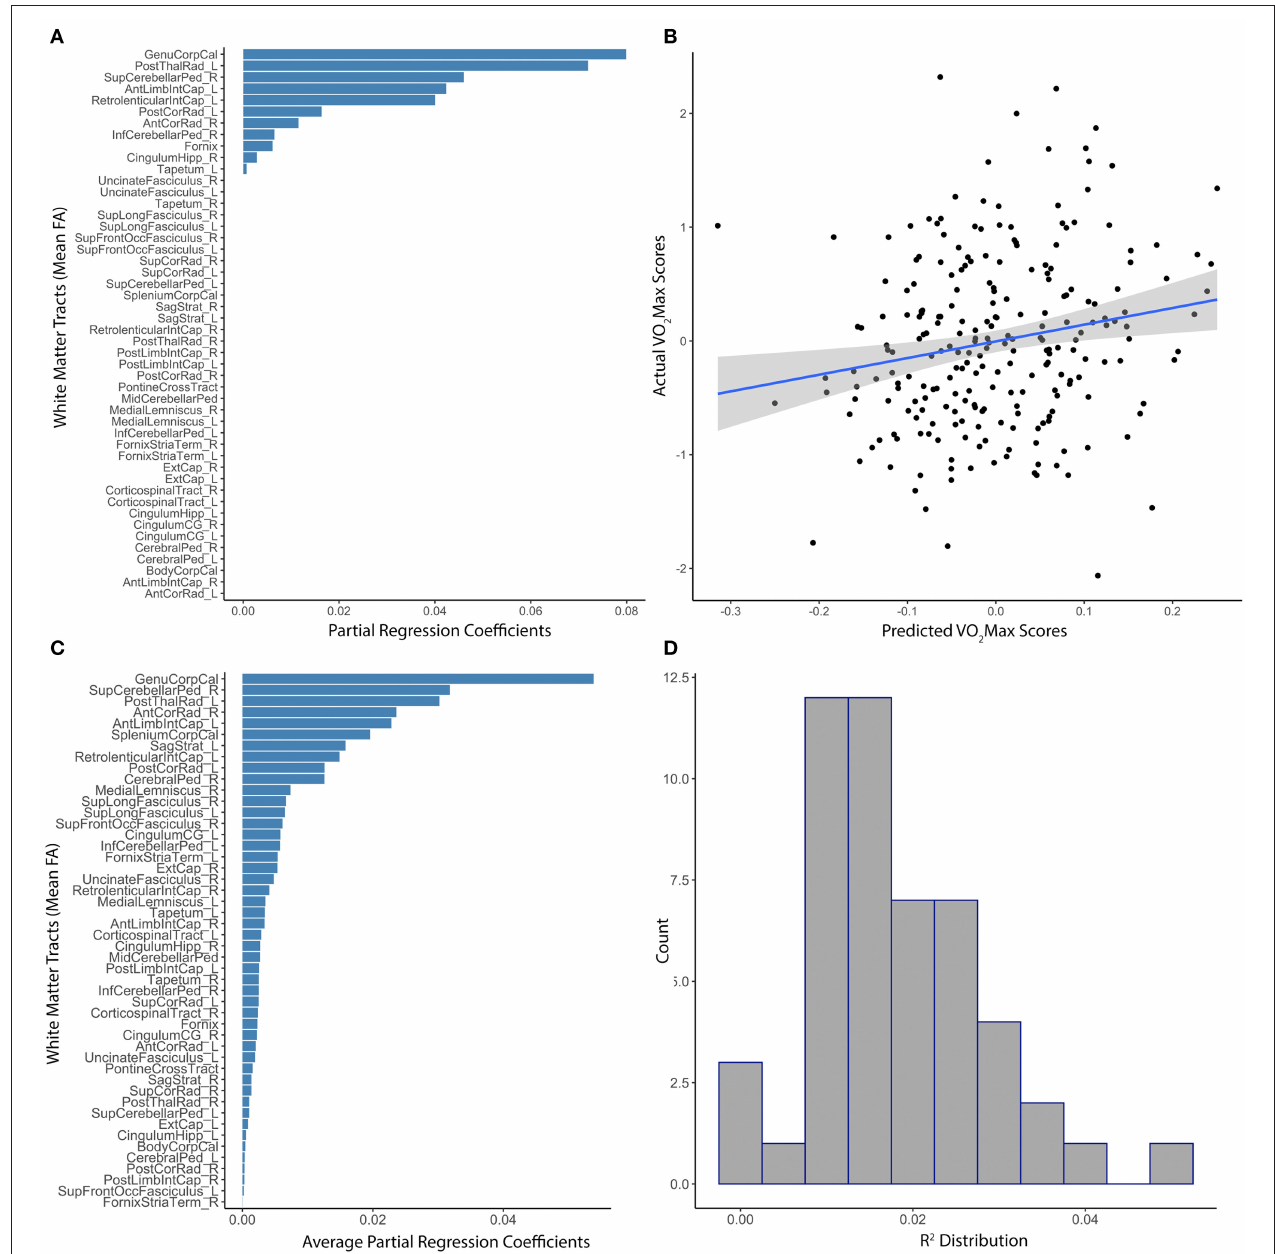
FIGURE 2 | Distributed white matter tract integrity and cardiovascular fitness. (A) The absolute value of partial regression coefficients for each tract that remained non-zero after training the initial elastic net model predicting residualized VO 2 Max. (B) Scatterplot of the correlation between model-predicted and actual sex-adjusted estimated VO 2 Max (centered and scaled) within the set-aside test subset ( R 2 = 0.028, p = 0.003). (C) Absolute value of the average partial regression coefficients for each tract from all iterations of the ensemble modeling. (D) Distribution of R 2 s gathered from the subsequent ensemble modeling using 1,000 iterations of the elastic net model (Ensemble R 2 = 0.013, 25th − 75th quartile =